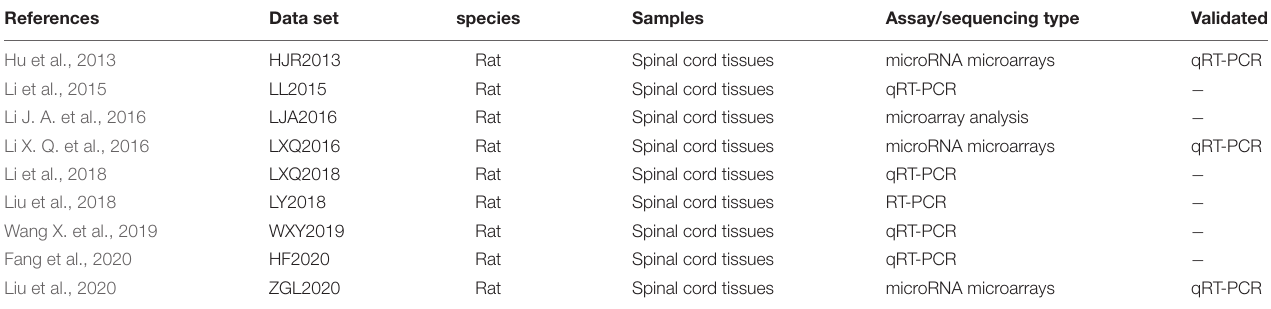
TABLE 2 | The basic characteristics of SCII DEmiRNA